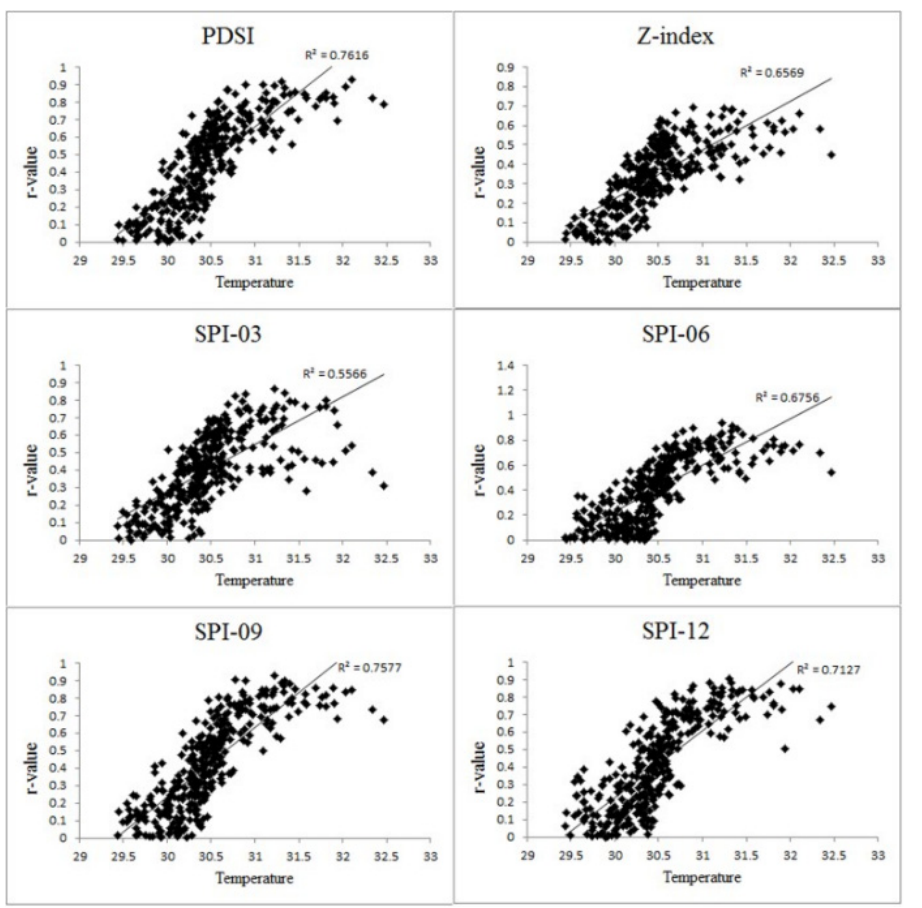
Figure 9. The correlations of r-values of VIUPD-derived VCI with in situ drought indices and mean temperature of the growing season from 2002 to 2011.